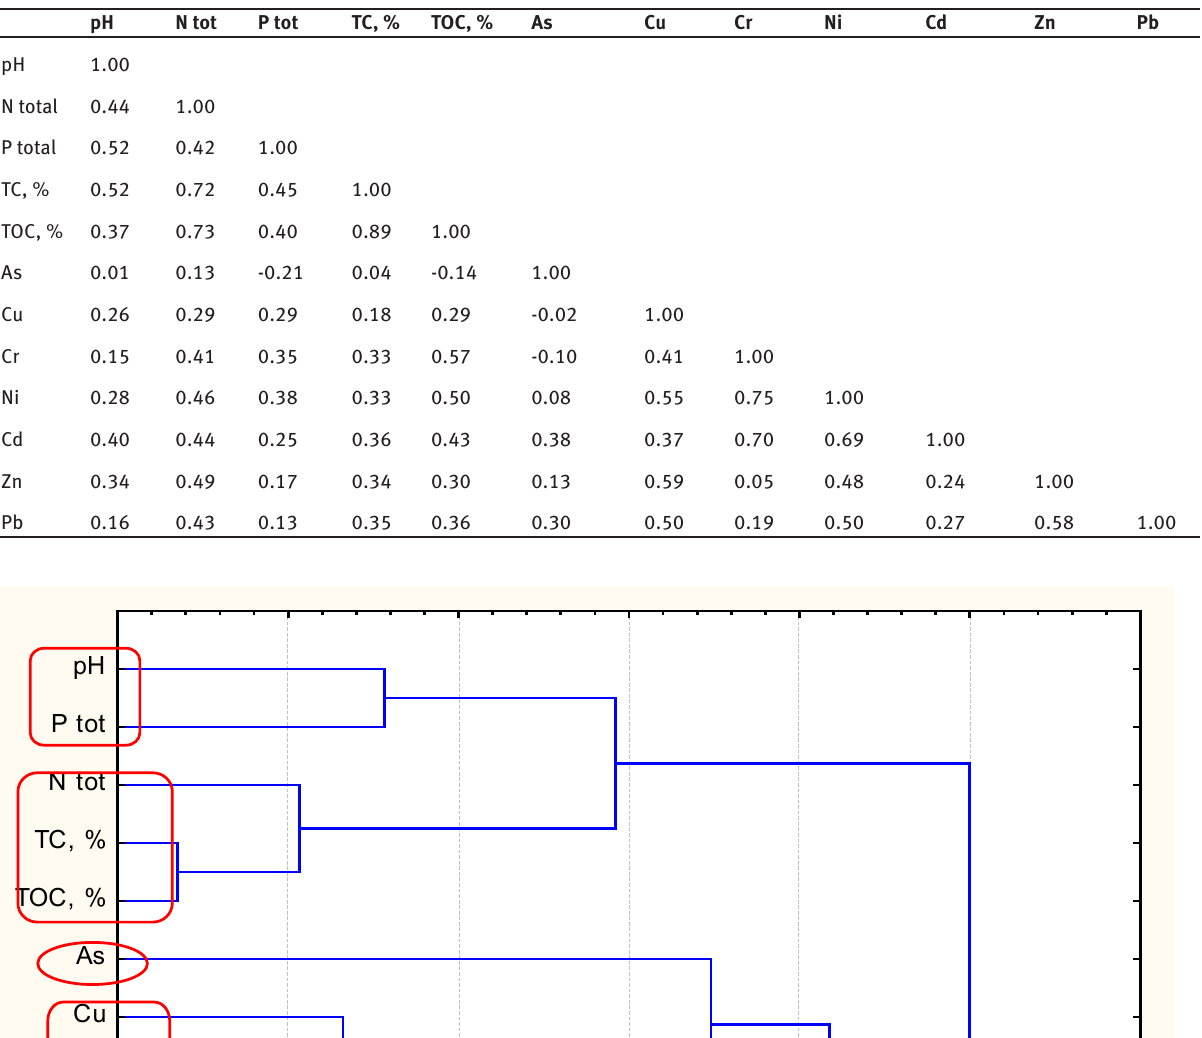
Table 2: Correlation matrix [12x12] (statistically significant correlations are marked).